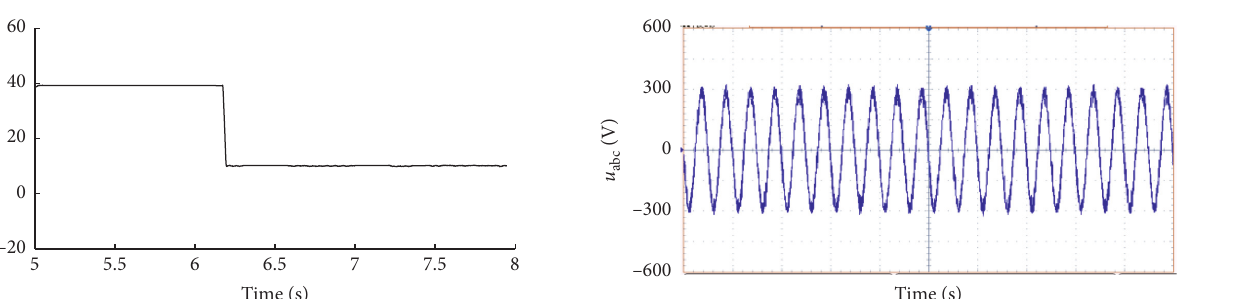
Figure 14: Experimental voltage waveform of the ESS (output power is set to 10kW).